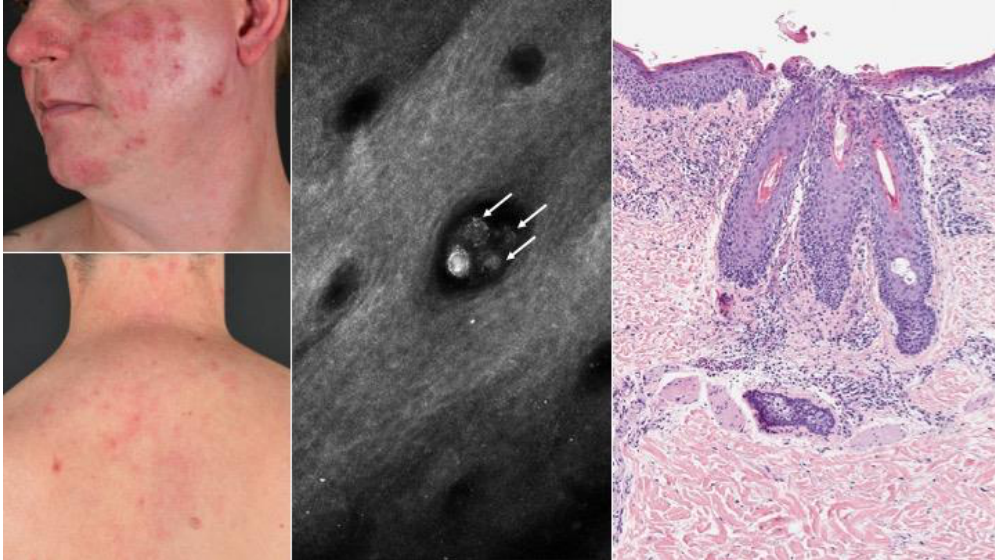
Figure 2. Atopic dermatitis with side effects of special interest. From left to right: Clinical picture of rosacea-like folliculitis lesions. Reflectance confocal microscopy (RCM) of Demodex mites. Mites emerge as multiple rounded structures within the hair follicles (arrows). Histopathology of a representative lesion showing typical features of folliculitis and perifolliculitis.